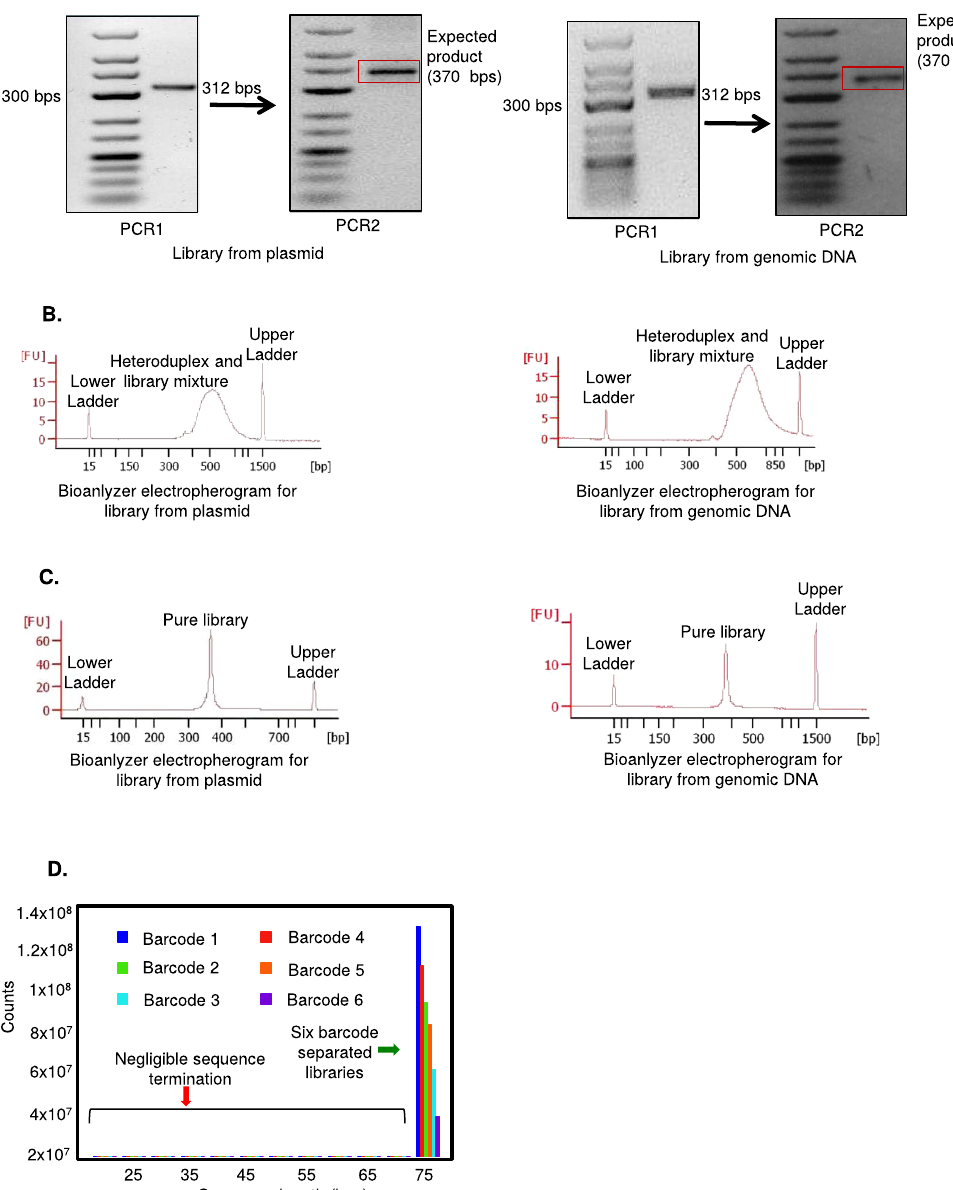
Figure 5. Steps involved in sequencing GeCKO library. ( A ) Gel image of barcoded library preparation of Gecko library from plasmid or gDNA. ( B ) Bioanalyzer electropherogram analysis showing formation of heteroduplex in barcoded CRISPR library from both plasmid and gDNA. ( C ) Bioanalyzer electropherogram analysis showing elimination of heteroduplex formation in CRISPR library from both plasmid and gDNA by reduced PCR cycles. ( D ) Read-length histogram showing Illumina sequencing results for the GeCKO library amplified from plasmid. CRISPR library is 76 bp after barcode separation. The sequence length is plotted in the X-axis and the sequence count is plotted in the Y-axis. Six different barcodes represent six different dilutions of the library, where consecutive dilutions cause comparatively lower library